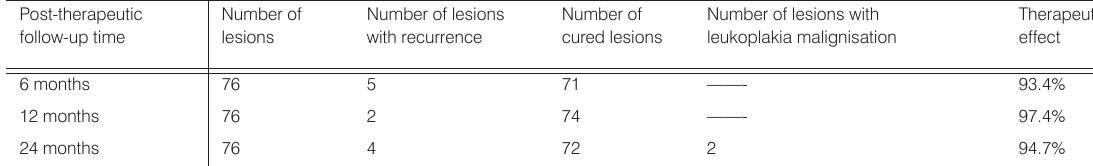
Table 8. Temporal development of the number of recurrences and malignisation in Group A Time of follow-up after diode laser therapy